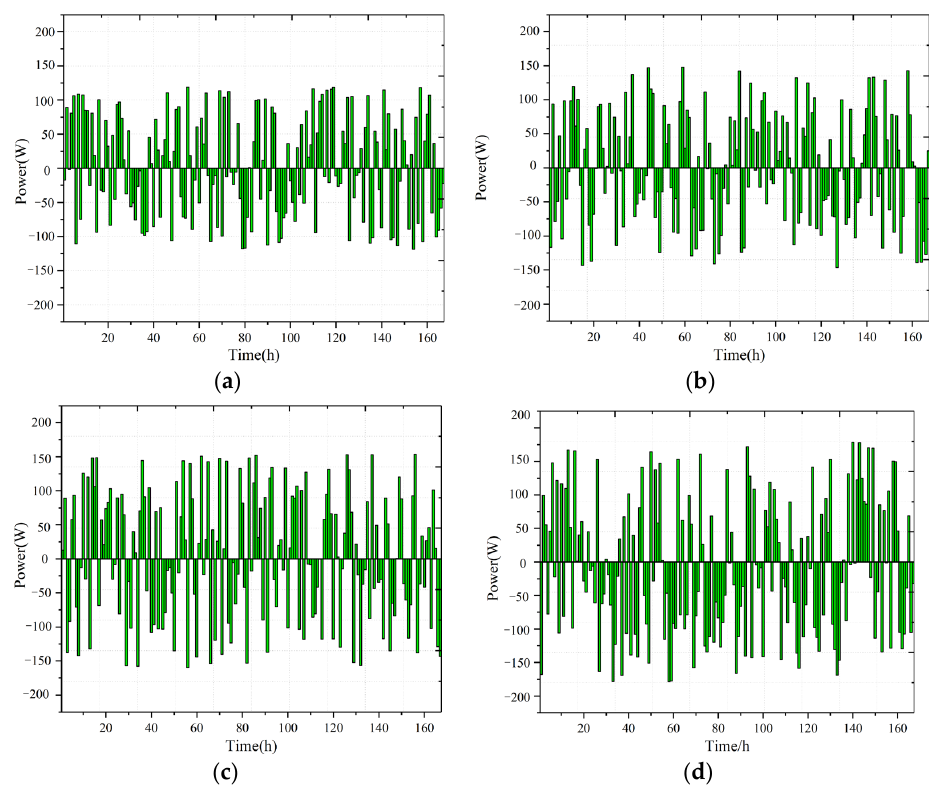
Figure 8. Model prediction deviation: ( a ) VMD− TCN; ( b ) VMD − LSTM; ( c ) TCN; ( d ) LSTM.